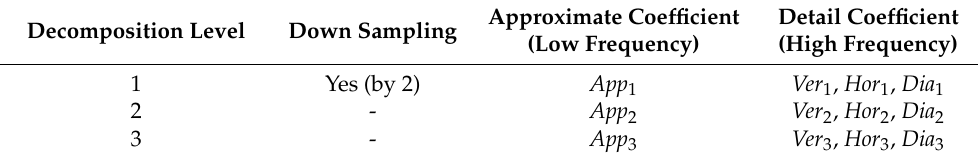
Table 3. Output coefficient for each level in 2-D stationary wavelet (SW)